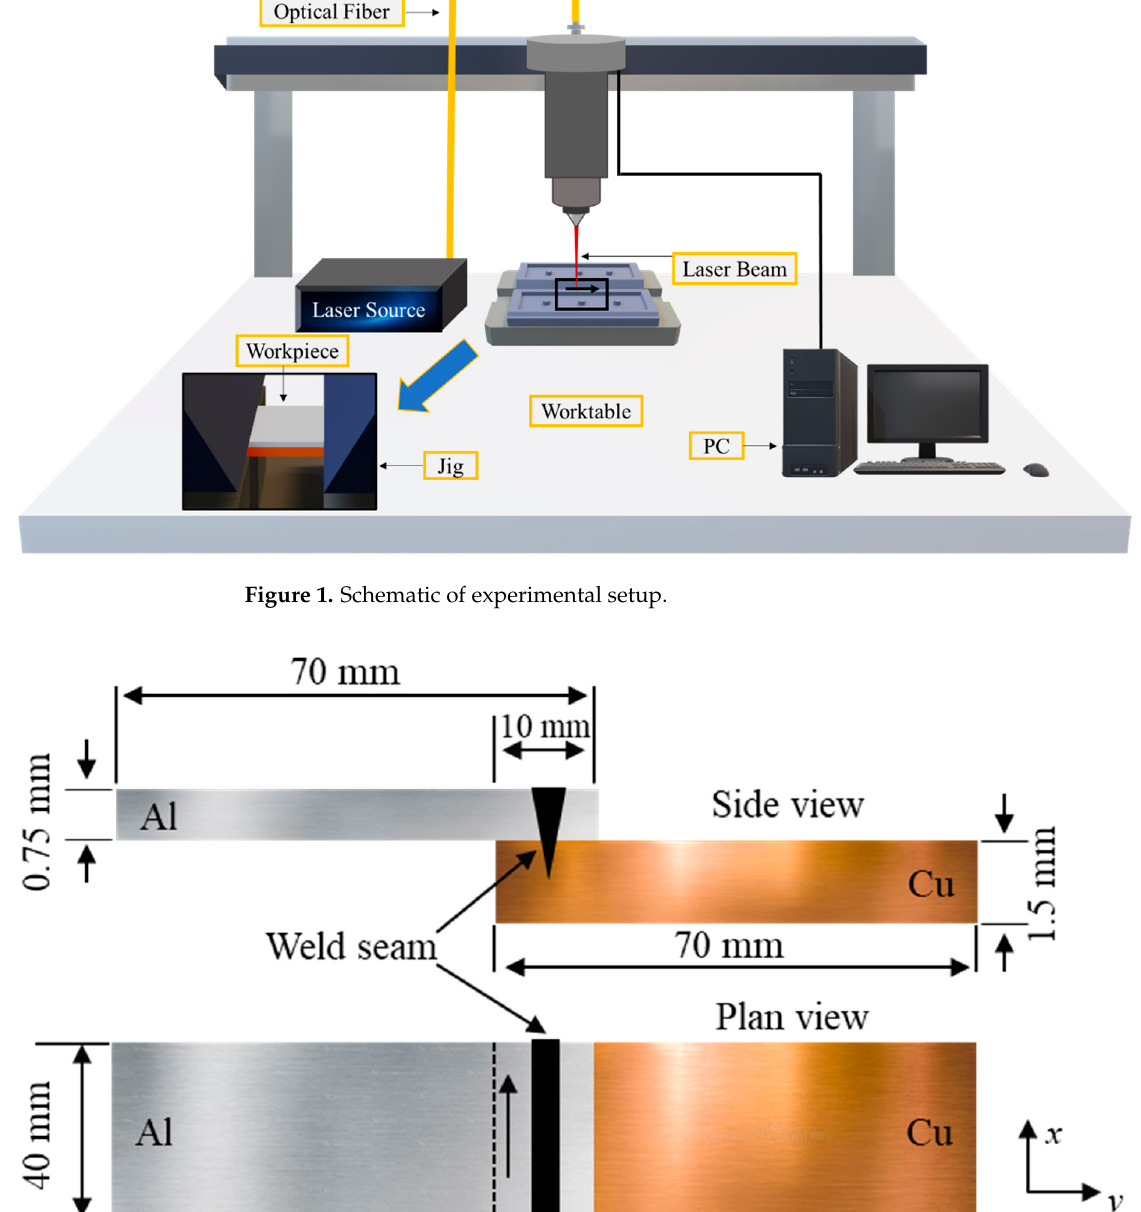
Figure 2. Schematic of the lap welding configuration. To obtain the full penetration conditions for the Al plate, three experimental groups named A, B, and C were designed with laser powers of 1500, 1600, and 1700 W, respec- tively, and the scan speed was varied from 15 to 30 mm/s in 5 mm/s increments for each power level. Laser welding was performed with the beam focused on the top surface of the Al plate using the experimental process parameters listed in Table 2. Table 2. Laser process conditions used in the experiment.